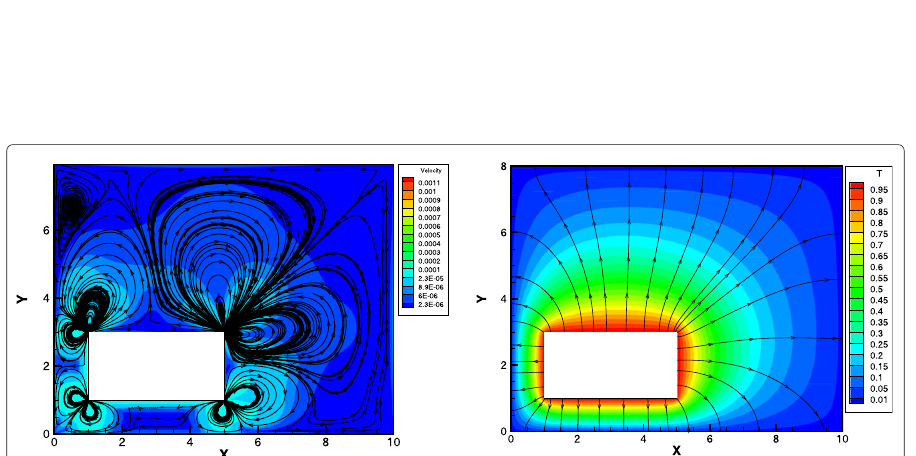
Fig. 16 Left figure shows the streamline of the microbeam flow with the velocity magnitude background, and right figure shows the heat flow of the microbeam flow with the temperature magnitude background